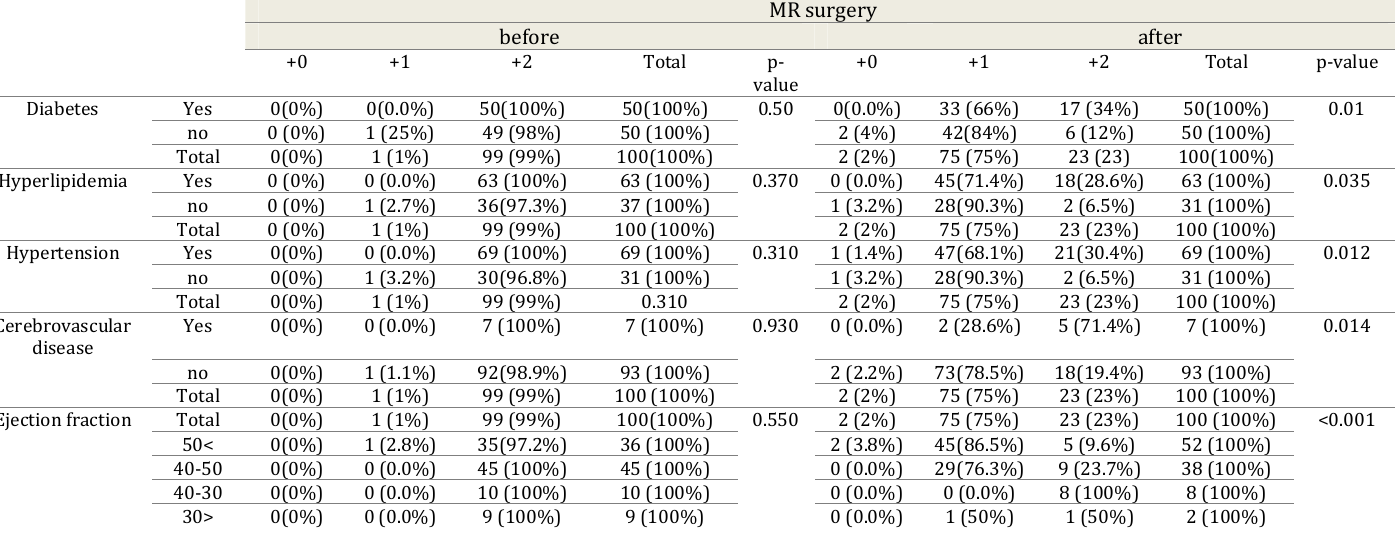
Table 1: Rate of Change in moderate MR according to underlying